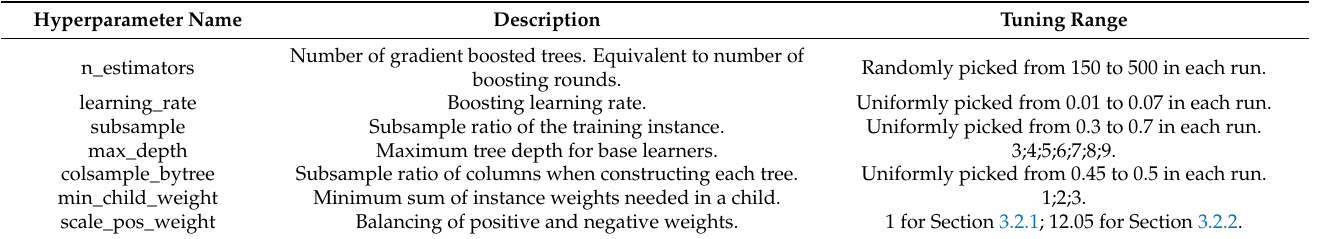
Table A1. Xgboost hyperparameters and tuning ranges for PRISMS data analyses.